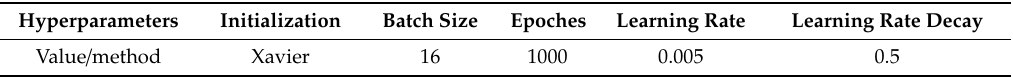
Table 3. Configuration of hyperparameters.